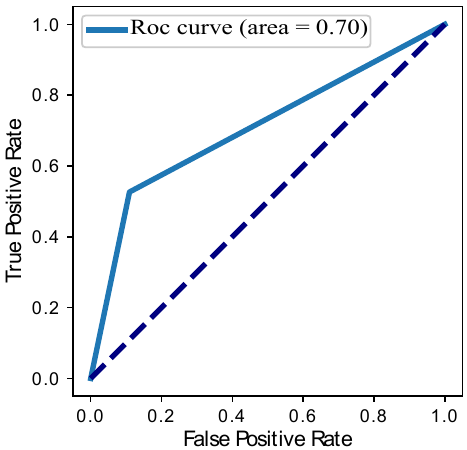
Figure 17. ROC curve of Decision Tree